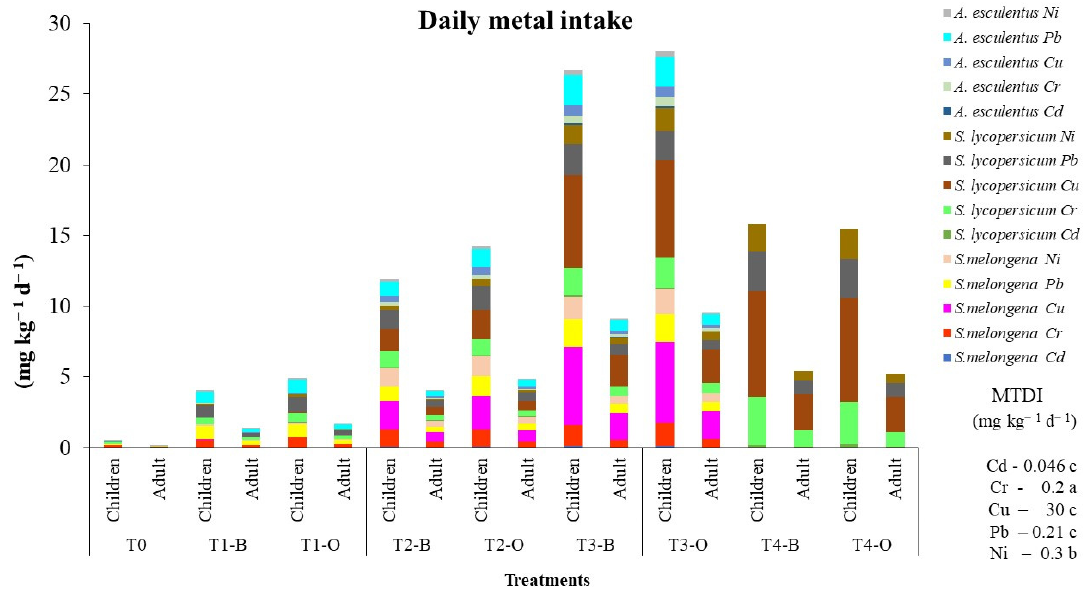
Figure 5. Daily intake of heavy metals via consumption of studied vegetables (mg kg − 1 d − 1 ) under different amendments. a RDA, 1989; b WHO, 1996; c JECFA, 2003; MTDI—maximum tolerable daily intake.